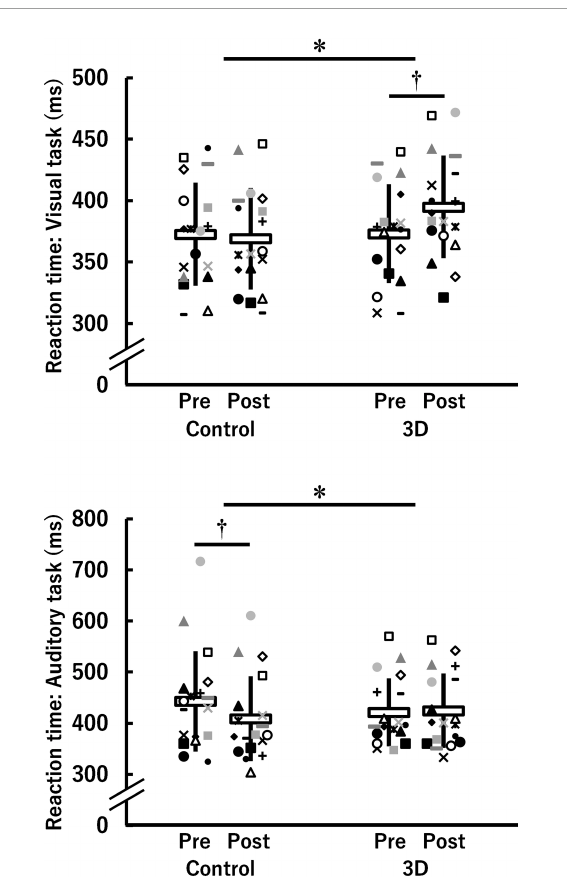
FIGURE3 Reaction time for the visual and auditory tasks before (Pre) and after (Post) watching a 1-h movie on television in 2D (Control) and 3D ( n = 18). ∗ Indicates a significant time (Pre, Post) × condition (Control, 3D) interaction ( P < 0.05). † Indicates a significant difference between Pre and Post in the same condition ( P < 0.05). The data were not normally distributed under some conditions and thus log-transformed during the analysis. White horizontal bars and thick solid lines in the vertical direction indicate means ± standard deviation of raw data, respectively. Each symbol indicates individual